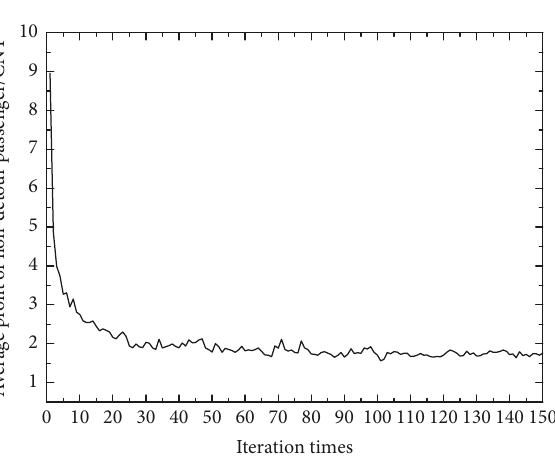
Figure 4: The evolution of passenger 𝐴 ’s average profit. Figure 5: The evolution of passenger